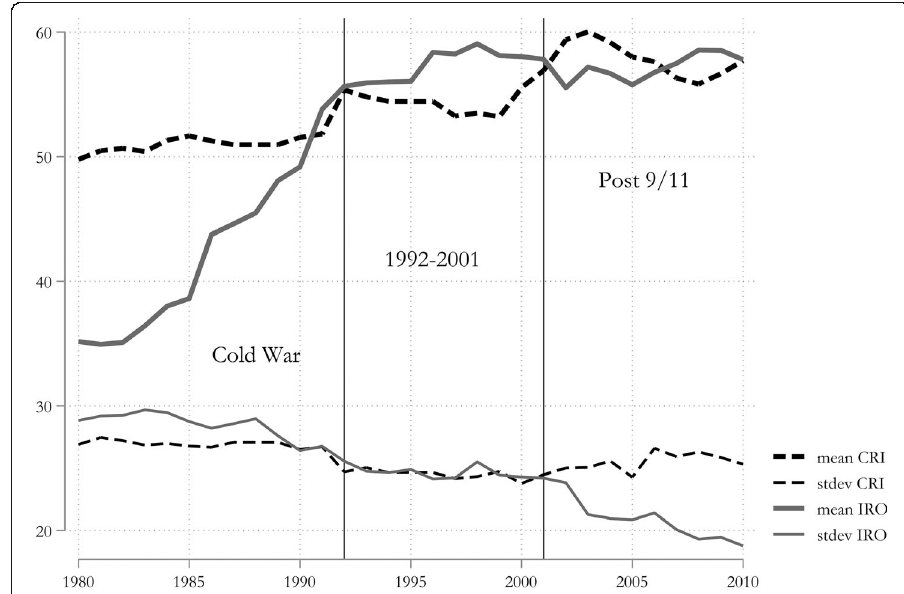
Fig. 3 Aggregate trends in IRO and CRI 1980 – 2010. Lines represent the mean and standard deviation of IRO and CRI, aggregated across 23 democracies from 1980 to 2010; reference lines indicate 1992 and 2001 to distinguish historical periods; IRO is based on selected policy components measuring the openness of immigration regimes according to IMPIC (Helbling et al. 2017). CRI is composed of the policy components of CITRIX (original dataset based on temporal expansion of selected items from MIPEX and based on the data by Stadlmair (2017) and Fitzgerald et al. (2014) and DEMIG and GLOBALCIT) measuring the inclusiveness of citizenship regimes